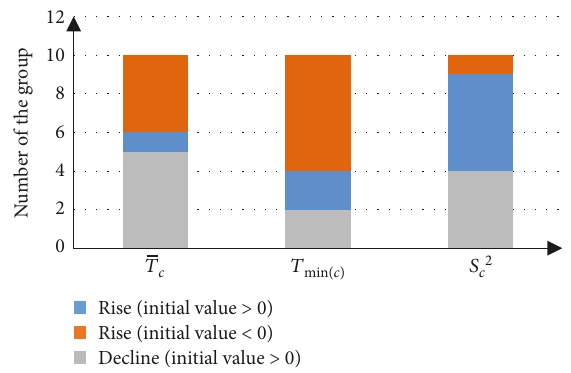
Figure 4: Variation of feature parameters in the normal printing stage.